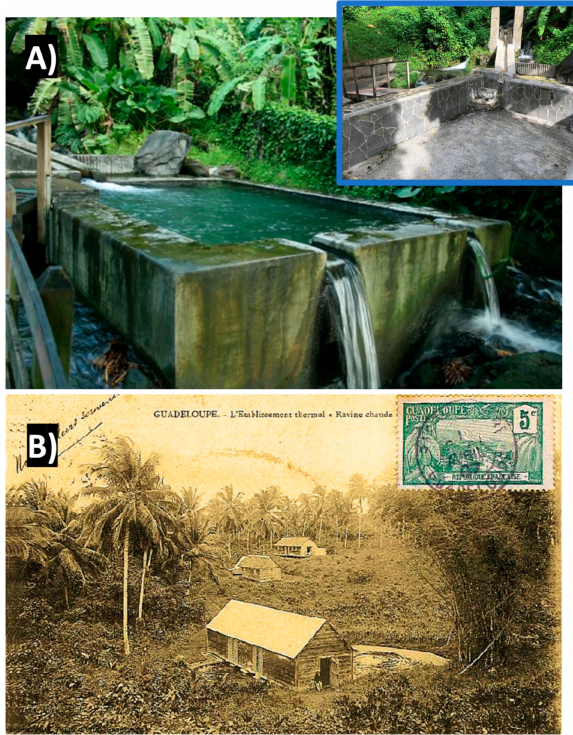
Figure 10. ( A ) 15 m 3 basin fed by Dol é hot spring waters. In the inset, the current empty basin status due to the diverted streamwater for safety reasons related to the ongoing andemic. ( B ) Historical postcard (dated 1907) of the Rivi è re Chaude thermal